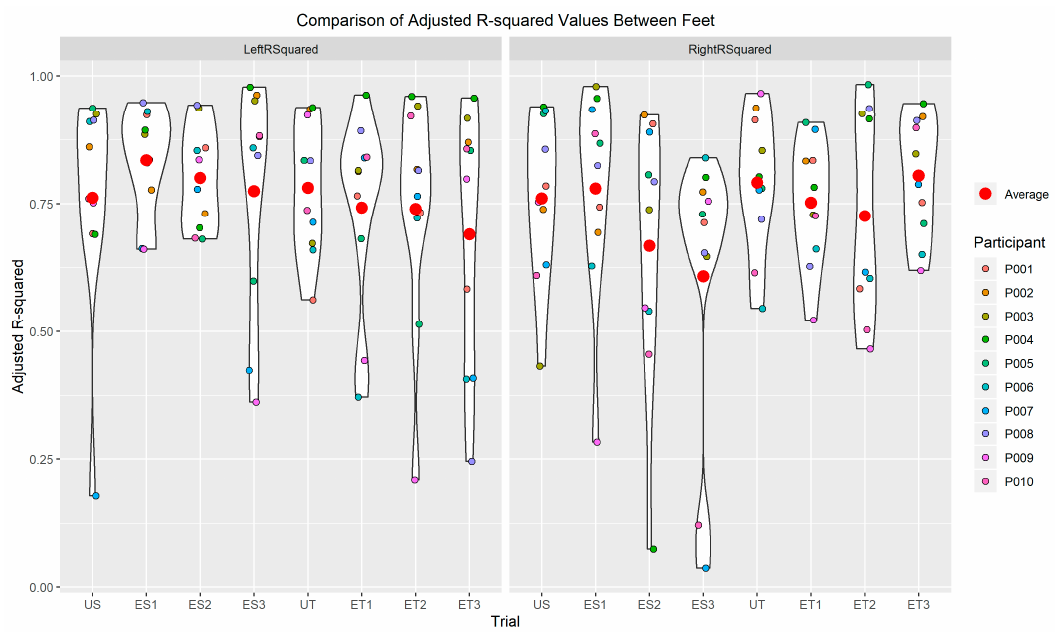
Figure 9. Spread, average, and individual data points of R-squared values for each trial across feet.